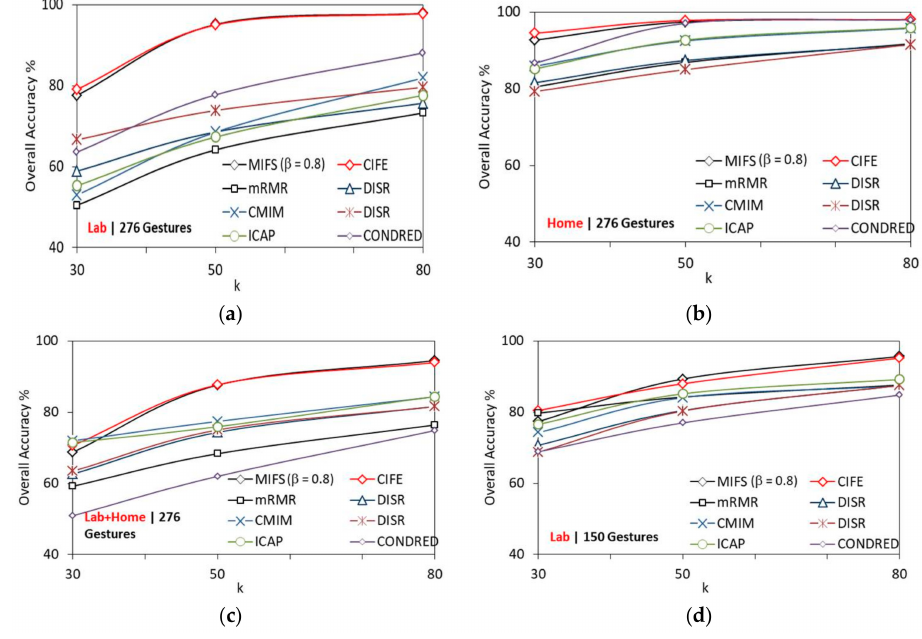
Figure 9. Comparison of feature selection algorithms with k ( a ) 276 gestures − lab dataset; ( b ) 276 gestures − home dataset; ( c ) 276 gestures − lab + home dataset; ( d ) 150 gestures − lab